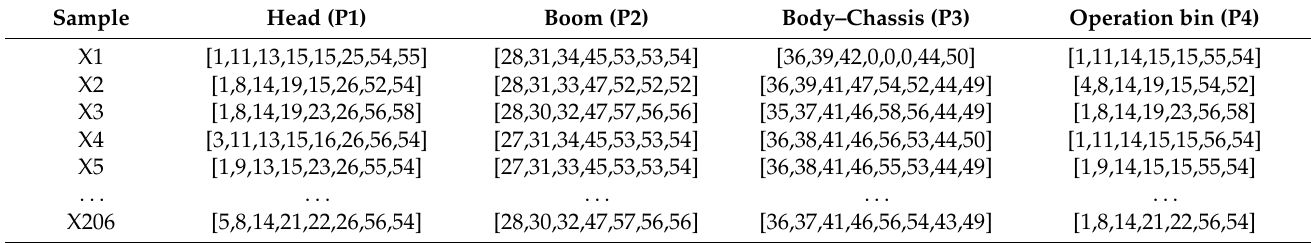
Table 7. Modeling-feature-category coding of truck cranes with visual sequence.